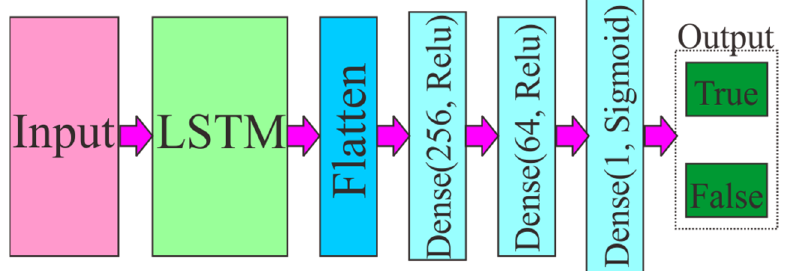
Figure 4. Simple LSTM-Based model for binary classification.